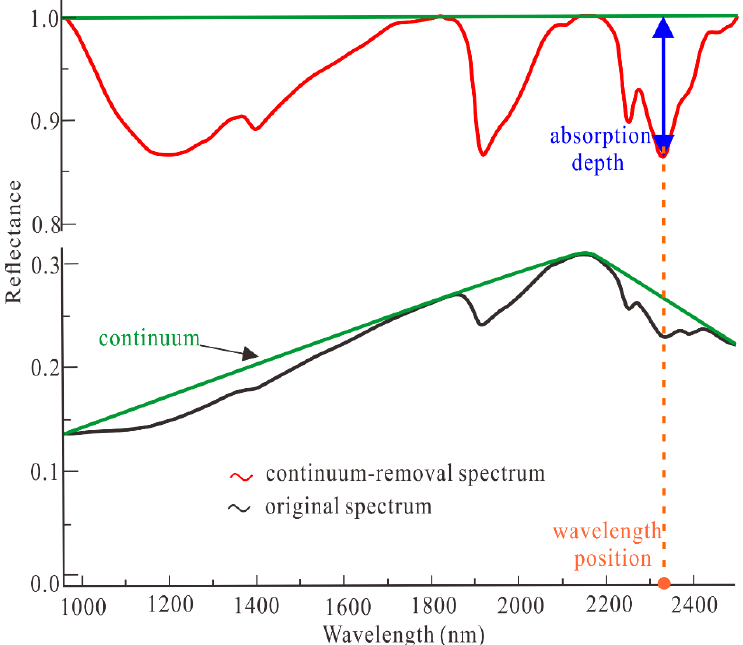
Figure 11. Comparison of original and continuum-removal spectrum.